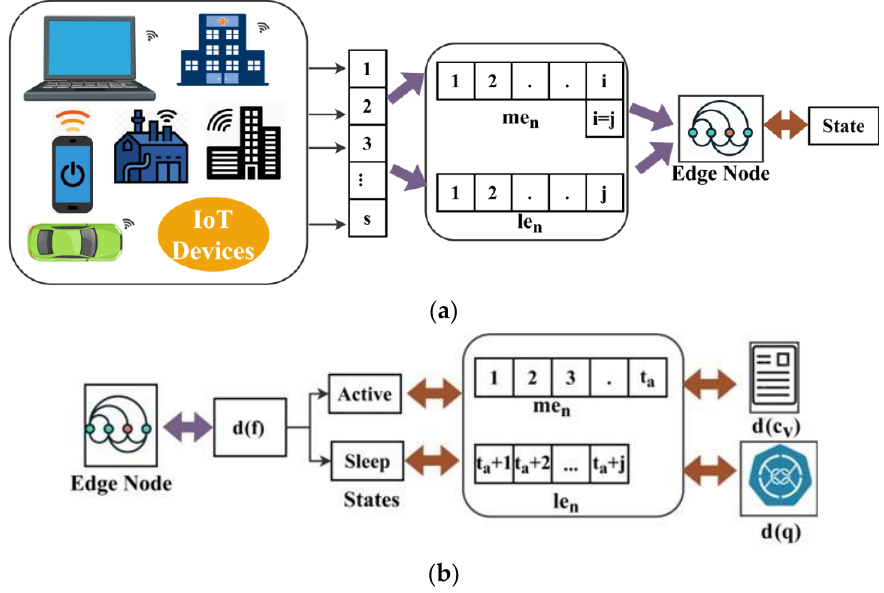
Figure 2. ( a ) Queuing data process based on node state, and ( b ) data allocation based on states.